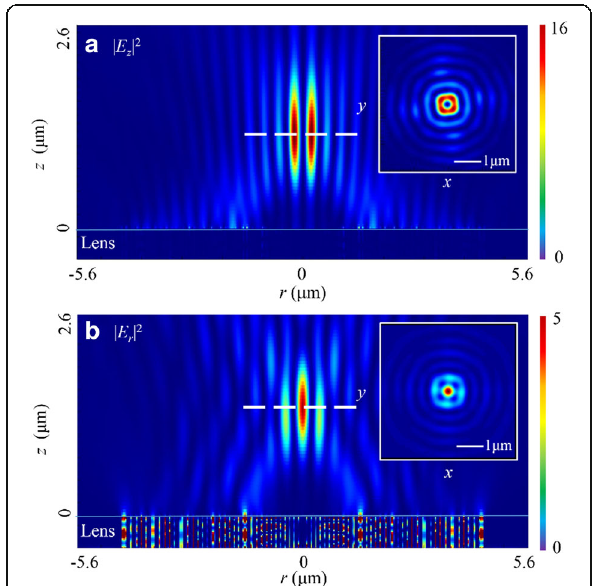
Fig. 6 Intensity distribution patterns of | E z | 2 and | E r | 2 in r-z plane in the case of circularly polarized light. a In | E z | 2 , the FWHM, DOF, and focal length is ~0.32 λ 0 , ~1.65 λ 0 , and 1185 nm, respectively. b In | E r | 2 , the FWHM, DOF, and focal length is ~0.45 λ 0 , ~1.68 λ 0 , and 1405 nm, respectively